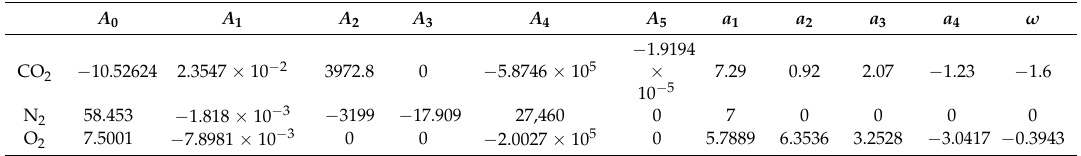
Table 3. Parameters for equilibrium constants of CO 2 , N 2 and O 2